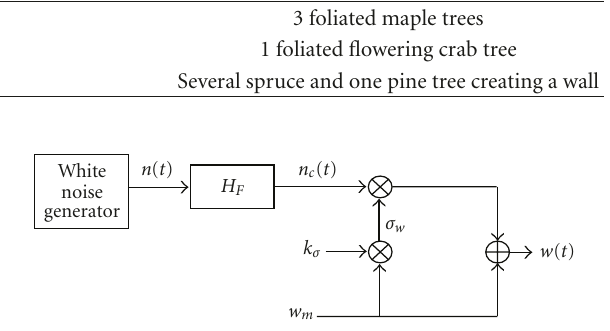
Figure 5: Model for simulating wind speed. n ( t ) is a white Gaussian noise with zero mean and unite variance, H F is the low-pass filter defined in (2), n c ( t ) is a colored noise, k σ is a model parameter (see Table 2), w m is the mean wind speed, σ w = w m k σ , and w ( t ) is the resulting wind speed. Table 2: k σ values for di ff erent terrain types at 10 meter height